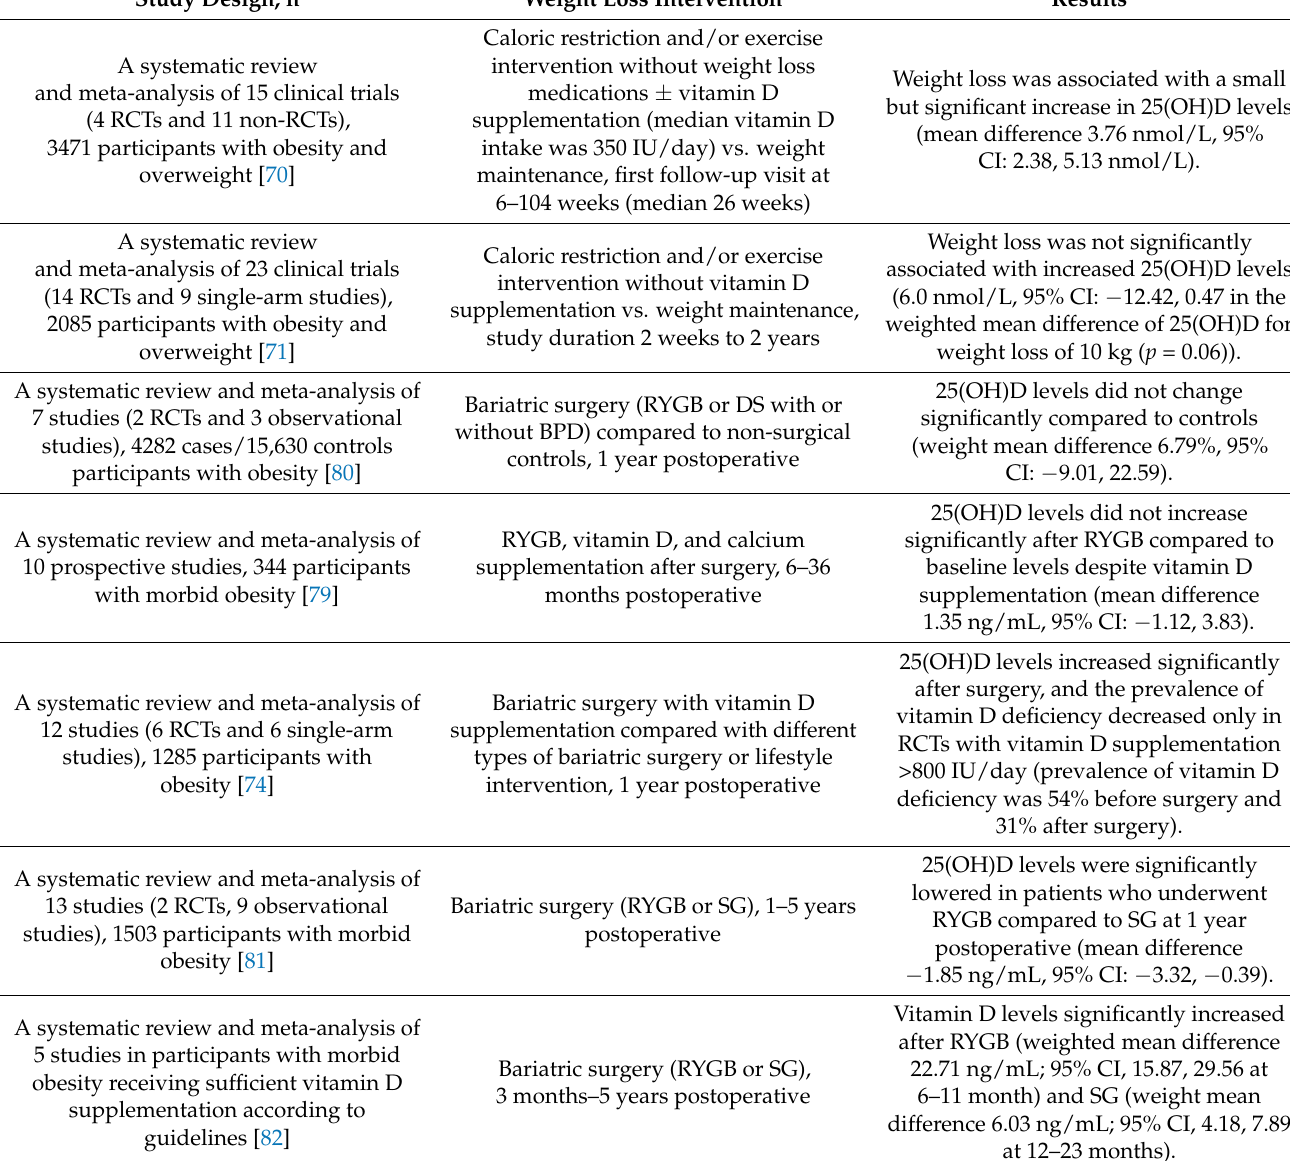
Table 4. The effect of medical and surgical weight loss on vitamin D